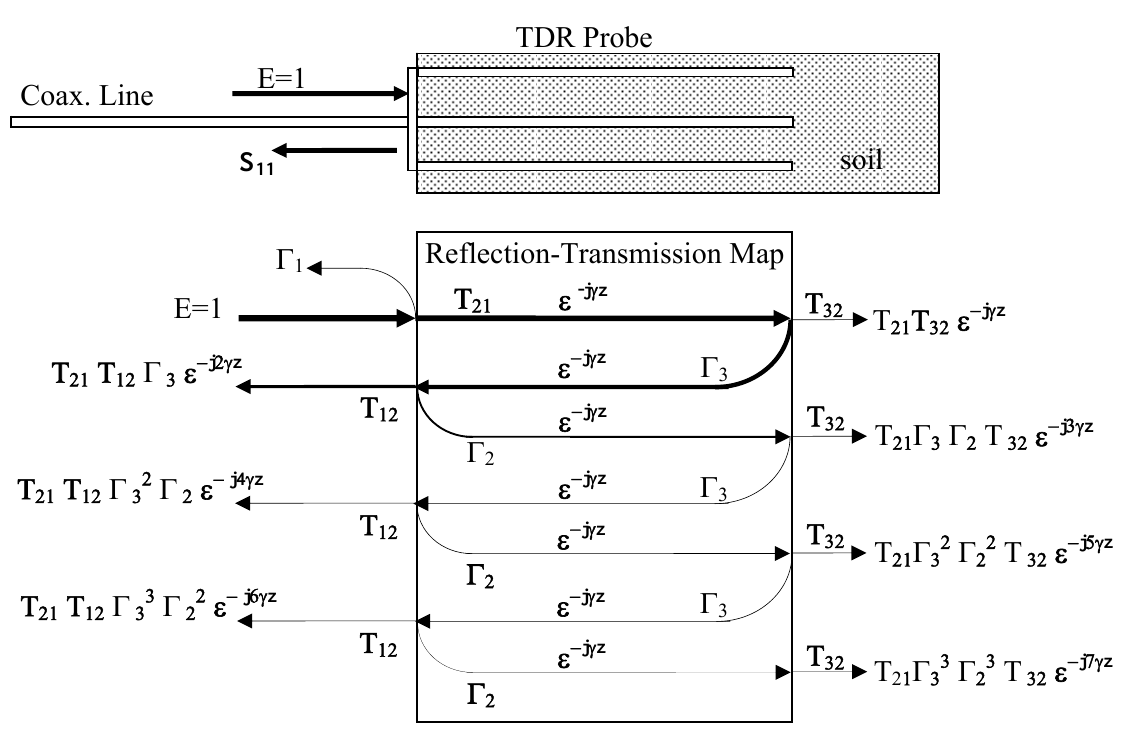
Figure 4. Detail of resultant waveform from combination of multiple reflections from both the leading edge (undesired) and probe end (desired) measurement, in TDR/FDR probes due to impedance mismatch between coaxial cable impedance Z impedance Z . Note: Hatched area indicates soil or other material under 1